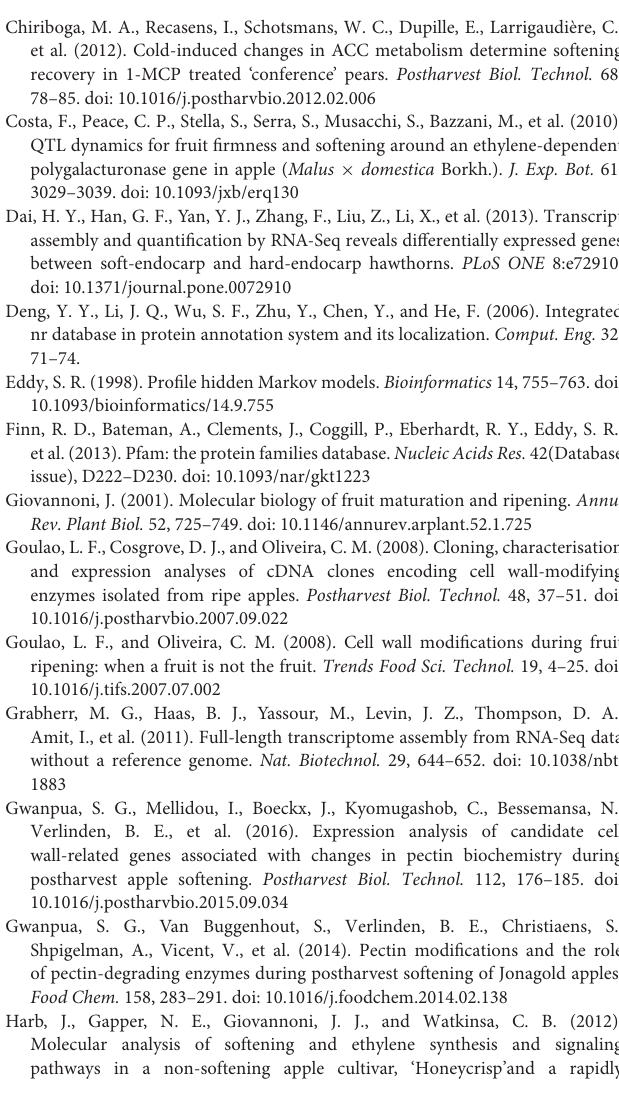
FIGURE S1 | Sequence of the amplification products for real-time PCR. FIGURE S2 | Nr function classification of assembled unigenes. The species distribution is shown relative to the total number of homologous sequences. FIGURE S3 | KOG function classification of the assembled unigenes. Overall, 12,143 unigenes were grouped into 25 COG classifications. FIGURE S4 | Differential gene expression profiles for different comparisons. (A) for RRSIVand QJXIV and (B) for RRSV and QJXV. Scatter plot of DEGs (FDR < 0.01 and FC ≥ 2) illustrating the full set of genes sampled. Red points: down-regulated genes; blue points: up-regulated; green points: genes that are not DEGs. FIGURE S5 | (A) Enriched top GO directed acyclic graph (DAG) of significant DEGs (molecular function) between RRSIV and QJXIV. (B) Enriched top GO directed acyclic graph (DAG) of significant DEGs (molecular function) between RRSVand QJXV. TABLE S1 | DEGs related to the cell wall in different textures of ‘Ruanrou Shanlihong 3 Hao’ and ‘Qiu JinXing’ fruits at two developmental stages. TABLE S2 | Primers for real-time